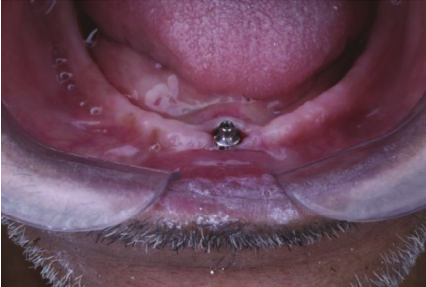
Figure 2: Ball attachment (Zimmer Company).